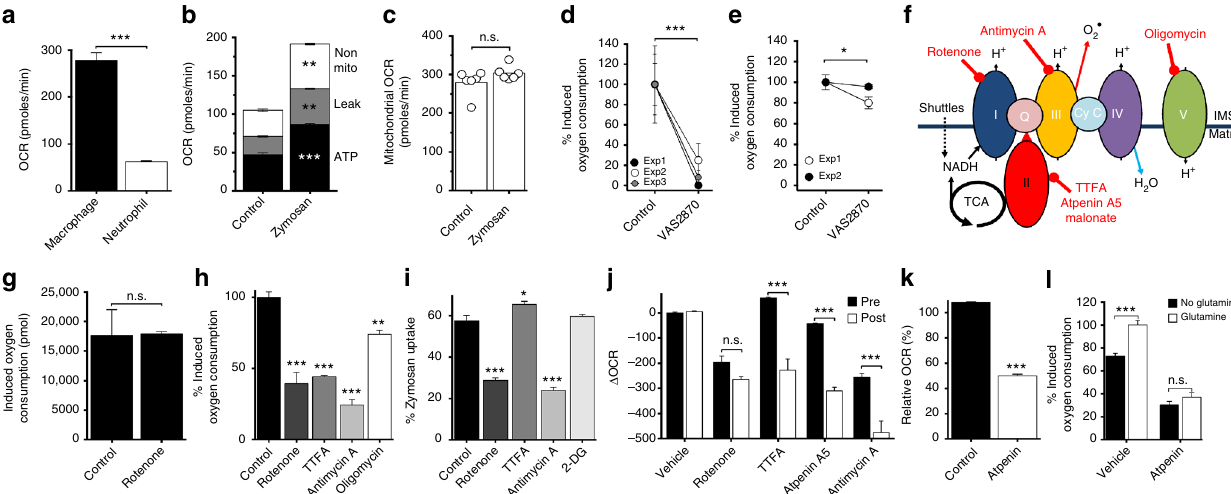
Fig. 5 Peritoneal tissue-resident macrophages enhance mitochondrial function during respiratory burst through a glutaminolysis enhancement of complex-II. a Peritoneal tissue-resident macrophage (pTRMØ) and neutrophil basal-OCR. Data show at least 10 wells per group and represents three observations. b Changes in mitochondrial parameters after zymosan (50 μ g/ml) to pTRMØ. Data ( n = 6 separate wells per group) represent three experiments analysed by paired two-way ANOVA (interaction p < 0.0001) with Sidak ’ s post-tests. c The maximal mitochondrial capacity from b . d Graph showing the total oxygen consumption of neutrophils after zymosan, ± VAS-2870 (10 μ M). Data (9 wells per group from three experiments) were analysed by two-way